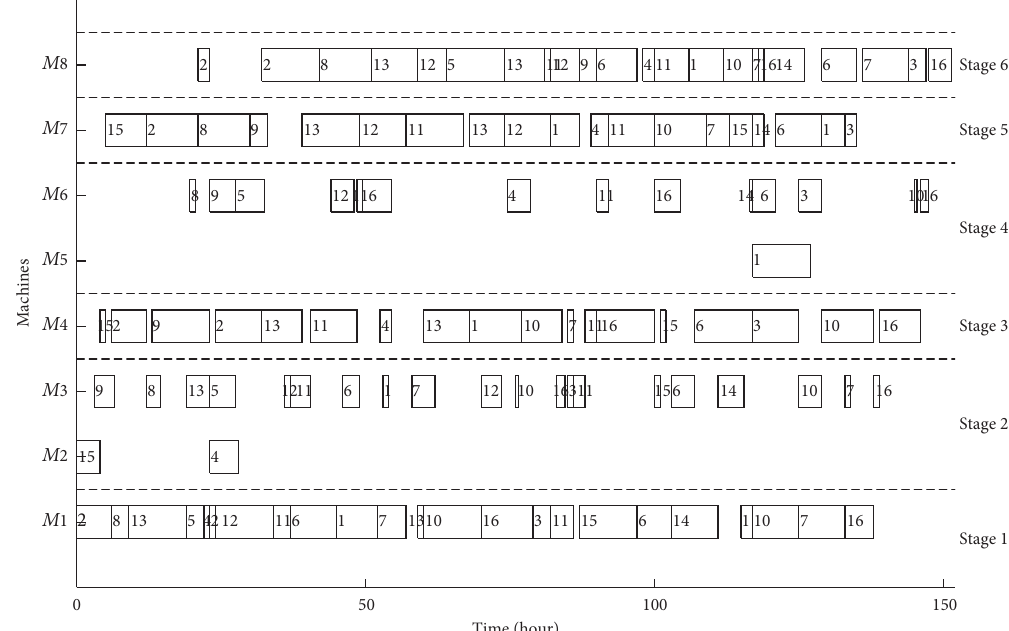
Figure 12: Gantt charts with right-shift operation under TOU electricity